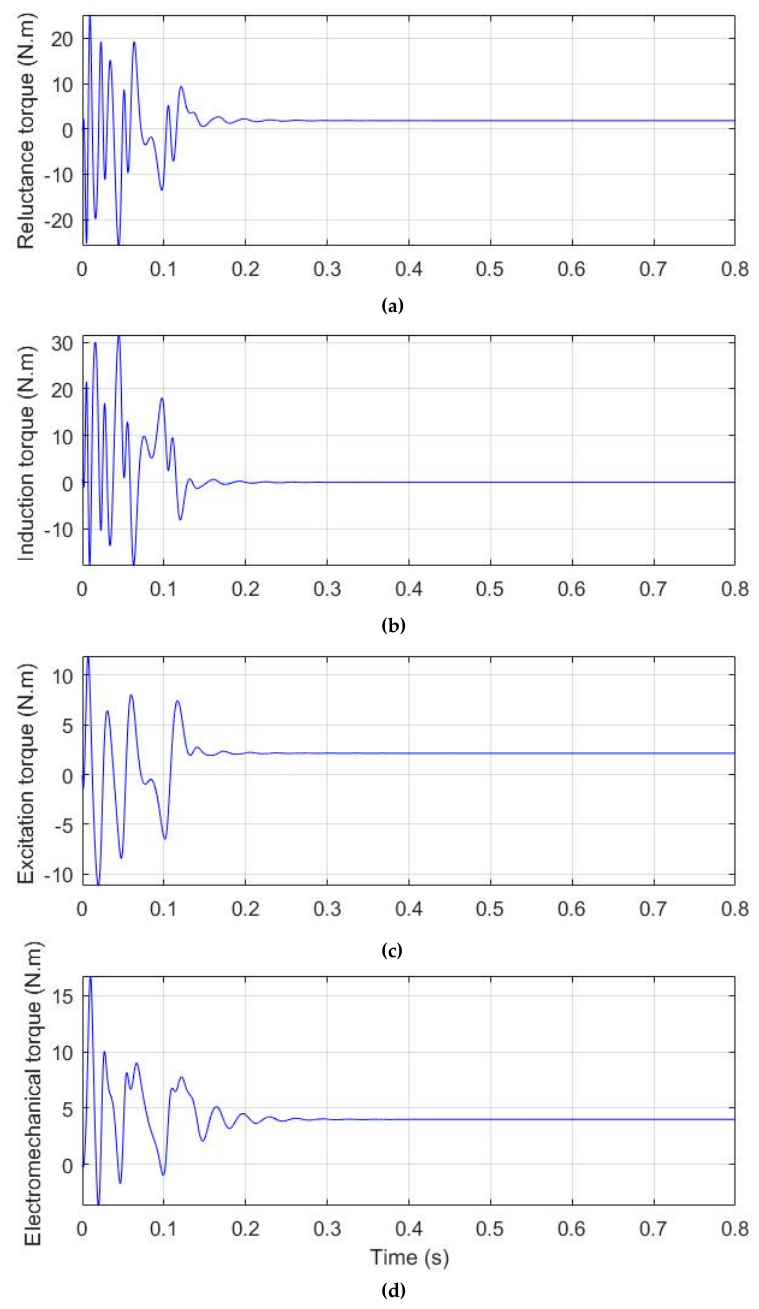
Figure 23. Motor torque components at full-load ( a ) reluctance torque ( b ) induction torque ( c ) excitation torque ( d ) electromechanical torque.